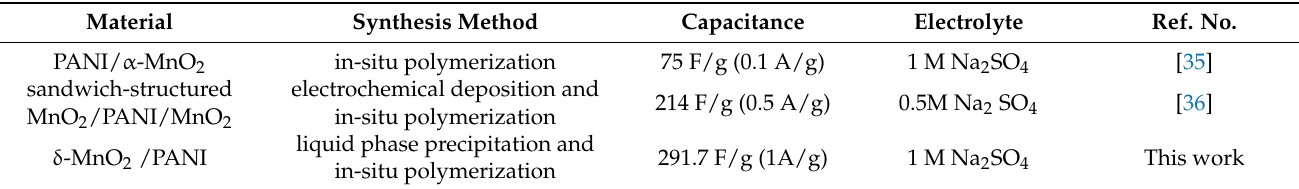
Table 1. Comparison among different PANI/MnO 2